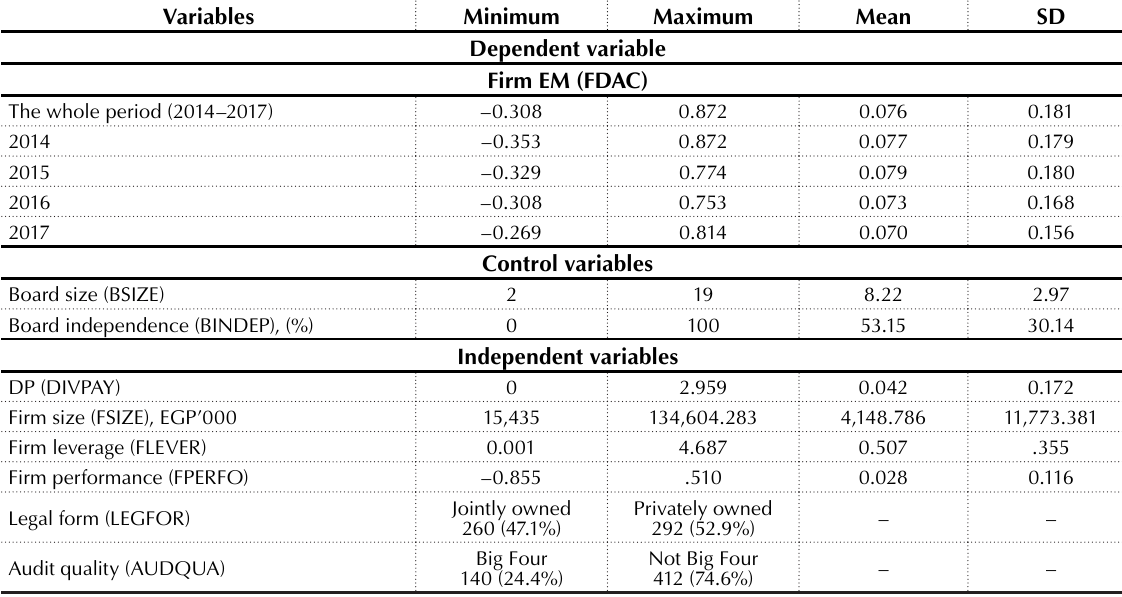
Table 3. Descriptive statistics of variables included in this